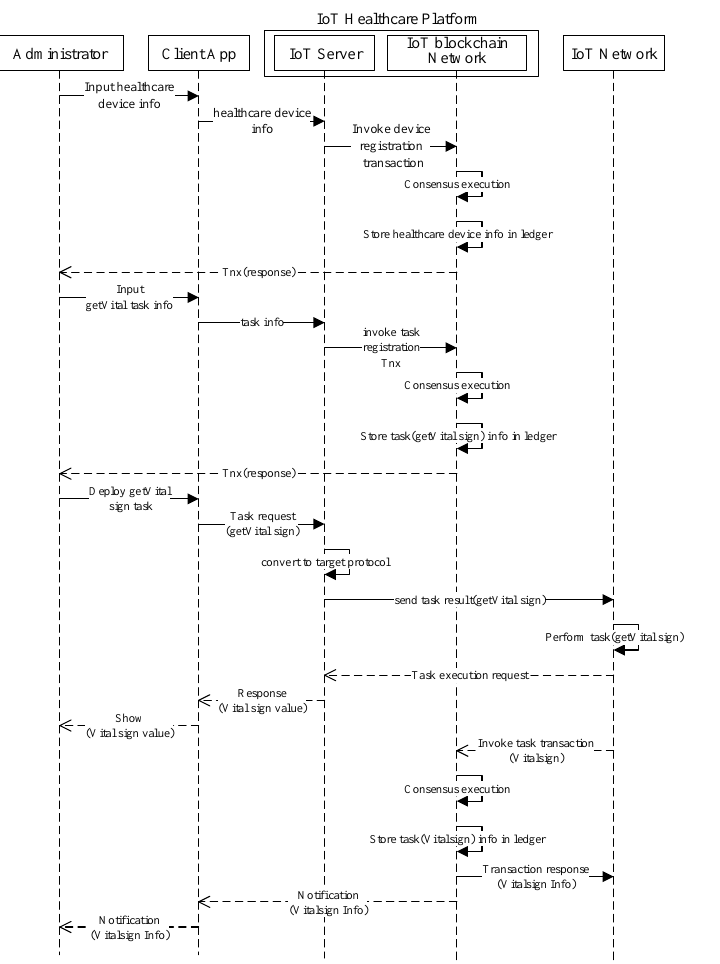
Figure 5. Sequence diagram of operation in the proposed healthcare IoT